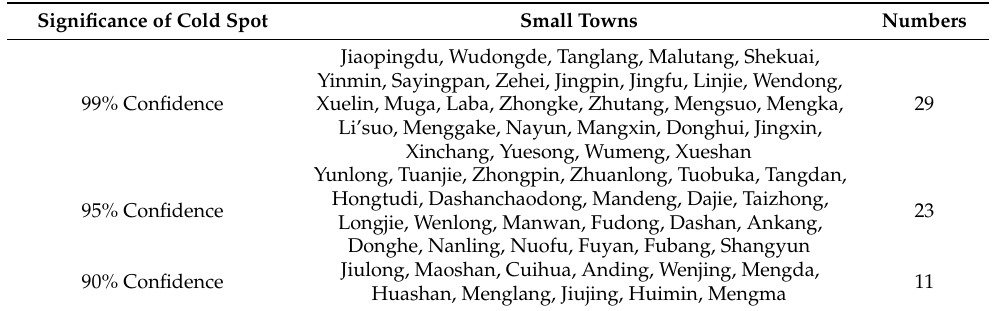
Table 7. Cluster results of transport location dimension (Cold spot). Significance of Cold